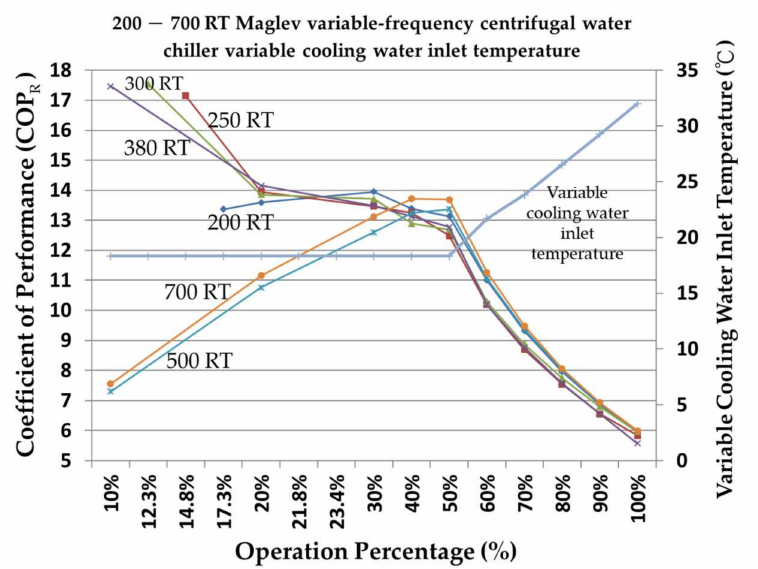
Figure 17. Variable-cooling water inlet temperature COP R of the 200–700 RT Maglev variable- frequency water chiller.